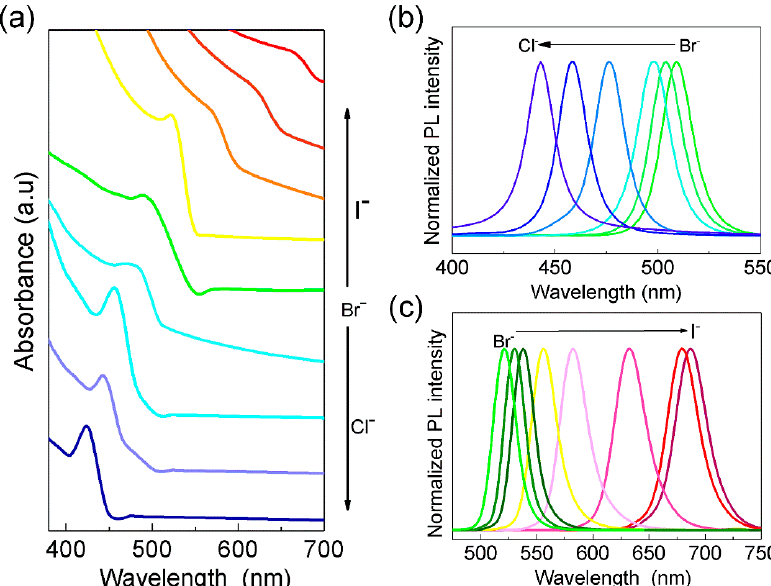
Figure 3. ( a ) Evolution of the UV-vis absorption spectra of samples that were prepared by the Cs 4 PbBr 6 n-hexane dispersion reaction with 0.5 mmol/mL KX (X = Cl, Br, and I) aqueous solution. ( b ) PL spectra of the exchanged NCs obtained from the Cs 4 PbBr 6 n-hexane dispersion by using ( b ) KCl and ( c ) KI aqueous solution as anion exchange resources.